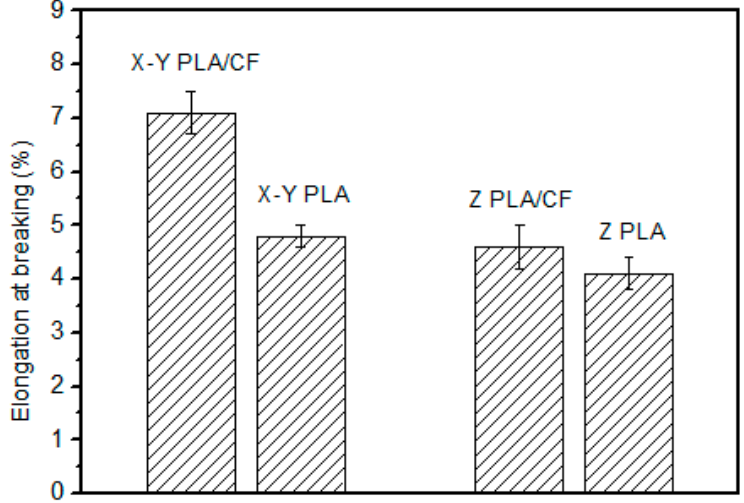
Figure 4. At breaking of the polylactic acid–carbon fiber (PLA–CF) specimens. 144